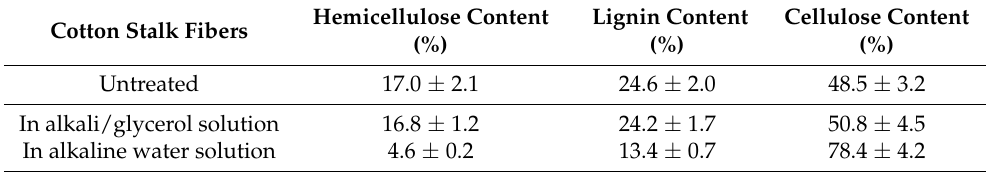
Table 2. Composition of the cotton stalk fibers treated in the solvent of glycerol and water.